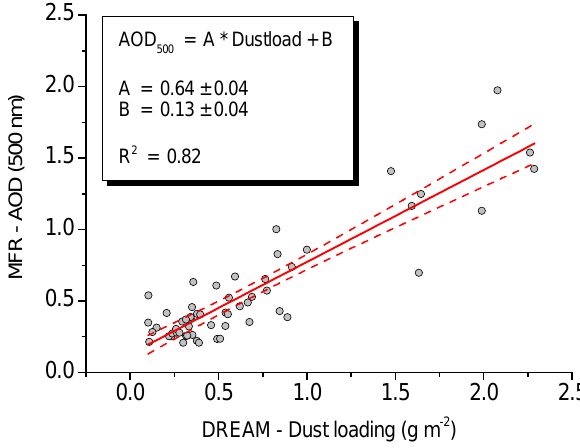
Figure 2. AOD at 500 nm from MFR versus dust loading from the BSC-DREAM model dur- Fig. 2. AOD at 500nm from MFR versus dust loading from the BSC-DREAM model, during selected dust cases that meet the cri- ing selected dust cases that meet the criteria given in Section 2.3. The thick red line is the re- teria given in Sect. 2.3. The thick red line is the regression line and gression line and the dashed lines represent the standard error at the 95% confidence level. the dashed lines represent the standard error at the 95% confidence level.